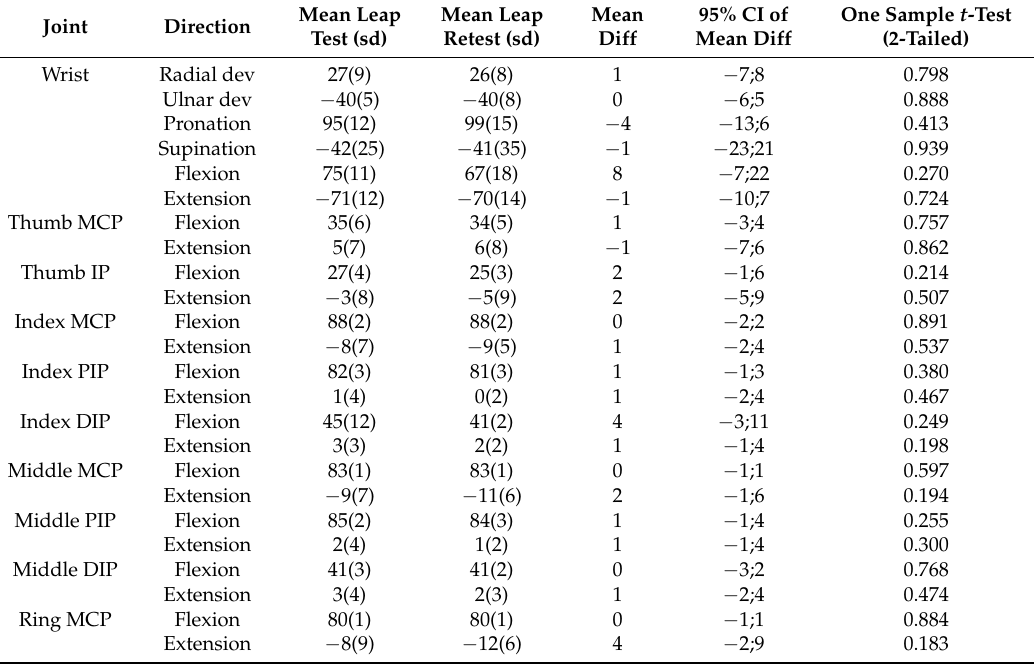
Table 2. Test and retest maximum joint angles for all joints in all directions of movement. Means and standard deviations (sd) are given. Mean differences, 95% Confidence Intervals for the mean differences and the p -value for the one sample t -test of comparing the mean difference to zero are also reported. Bold letters indicate the joints and movements for which the test retest did not reach a good